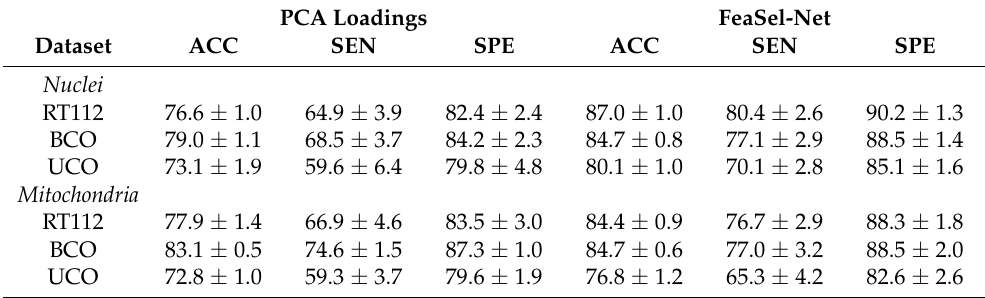
Table 3. Classification performance of masked Raman data. The presented values ( ± SD) are the parameters’ percentage averages of 10 training runs for each dataset and feature selection